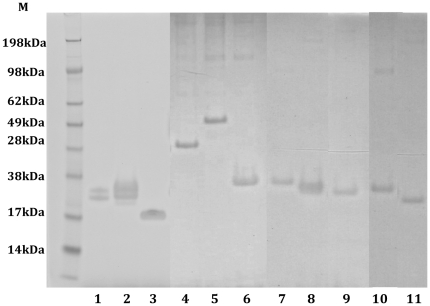
SDS-PAGE of the purified S2 cell expressed truncated MSP1-42 proteins.Expected molecular sizes of each construct are in parenthesis. Lane 1: Construct 33-A (19 kDa); Lane 2: Construct 33-B (21 kDa); Lane 3: Construct 33-C (14 kDa); Lane 4: Construct 33-D (29 kDa); Lane 5: Construct 33-E (32 kDa); Lane 6: Construct 33-F (39 kDa); Lane 7: Construct 33-G (21 kDa); Lane 8: Construct 33-H (19 kDa); Lane 9: Construct 33-I (17 kDa); Lane 10: Construct 33-J (21 kDa); Lane 11: Construct 33-K (19 kDa).